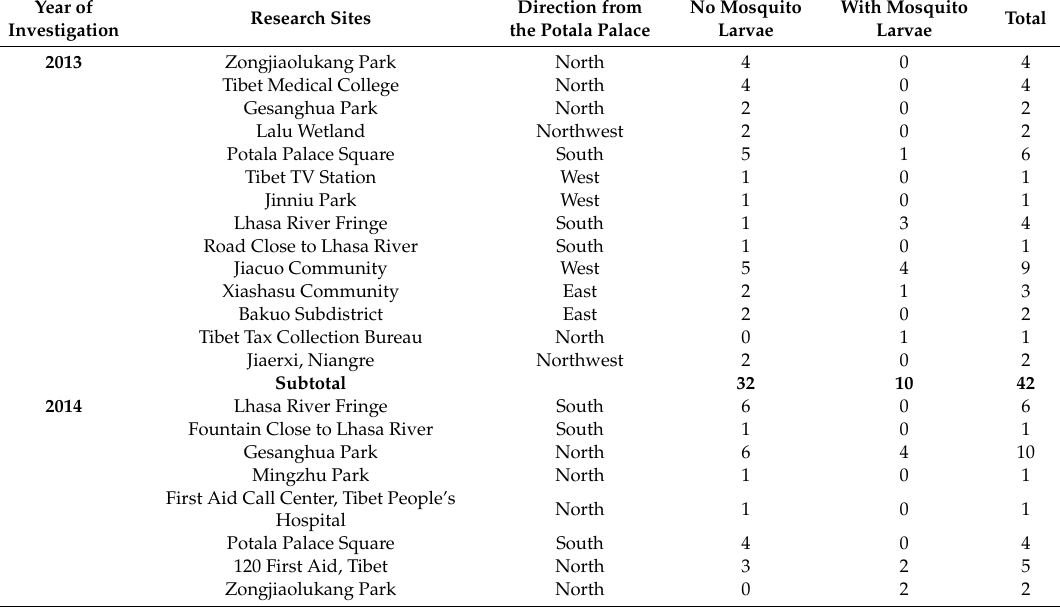
Figure 1. The research sites of this study. Table 1. Locations of positive larvae breeding sites in Lhasa, 2013–2016,